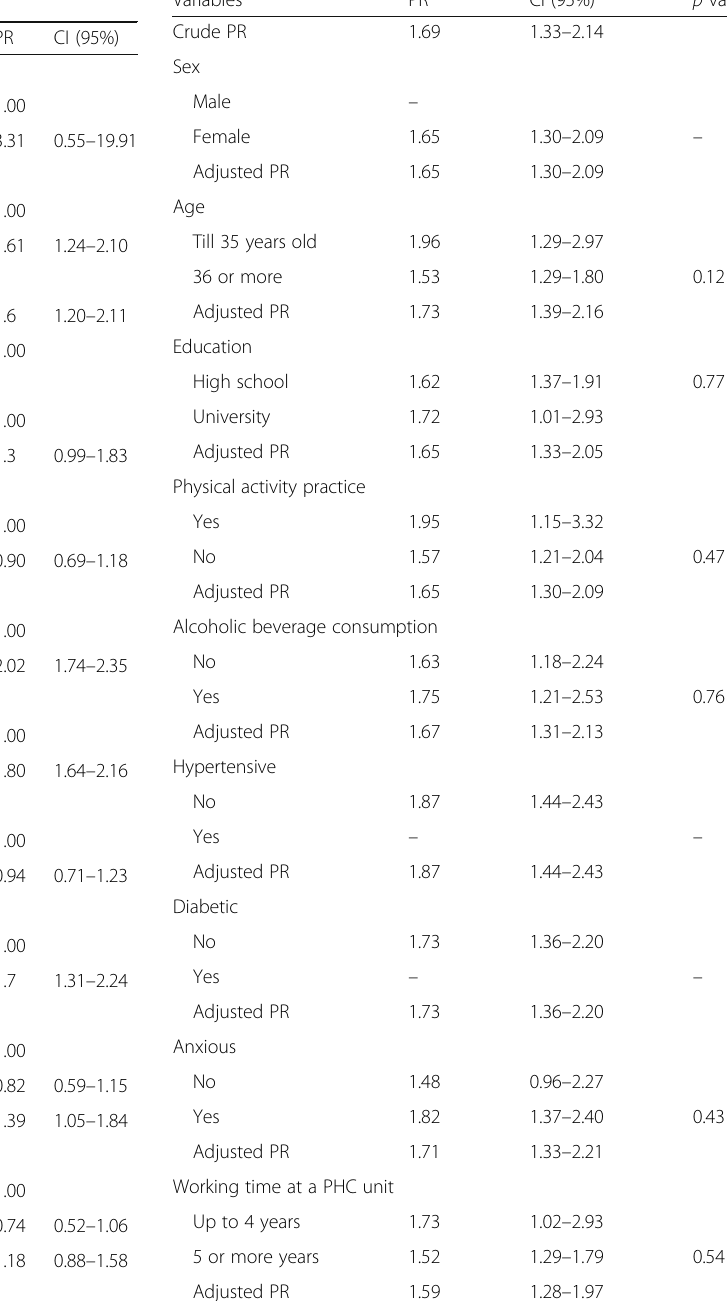
Table 3 Association between burnout syndrome and abdominal adiposity by strata of sociodemographic and occupational characteristics, lifestyle, and morbidity,